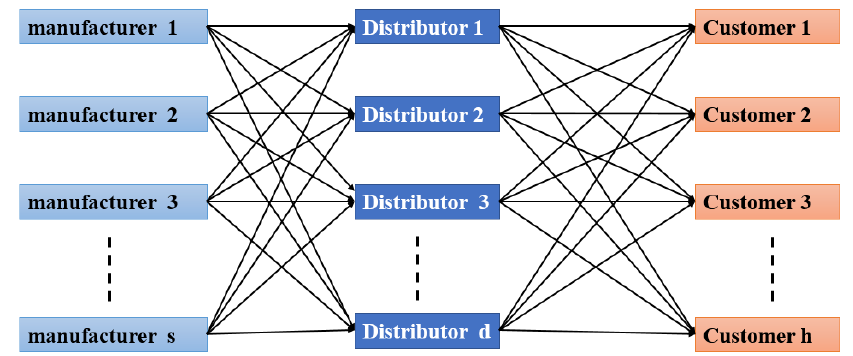
Figure 2. Supply Chain network design Model Assumptions.